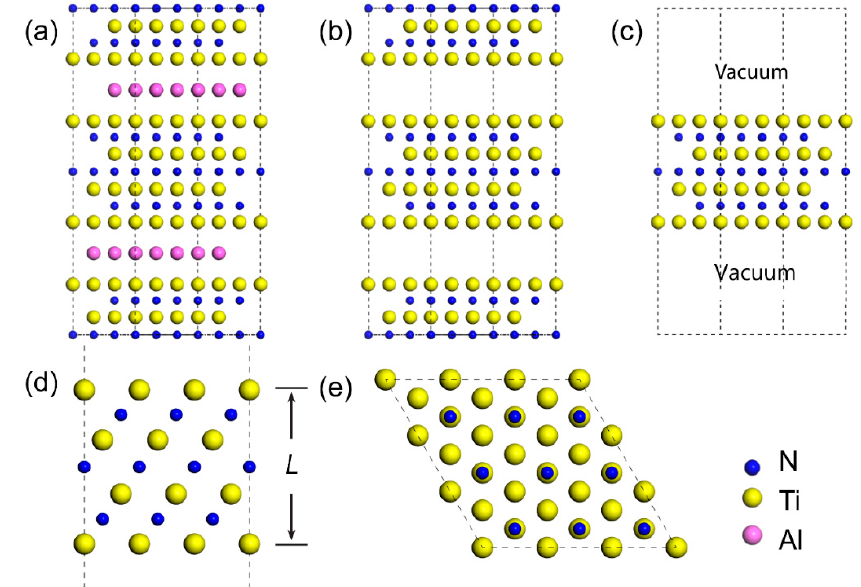
Figure 1. Schematic of construction processing of the Ti 4 N 3 MXene nanosheet by etching off the Al atomic layer from the Ti 4 AlN 3 bulk. ( a ) Ti 4 AlN 3 bulk, ( b ) Ti 4 N 3 bulk and ( c ) front, ( d ) side and ( e ) top view of the Ti 4 N 3 MXene nanosheet.